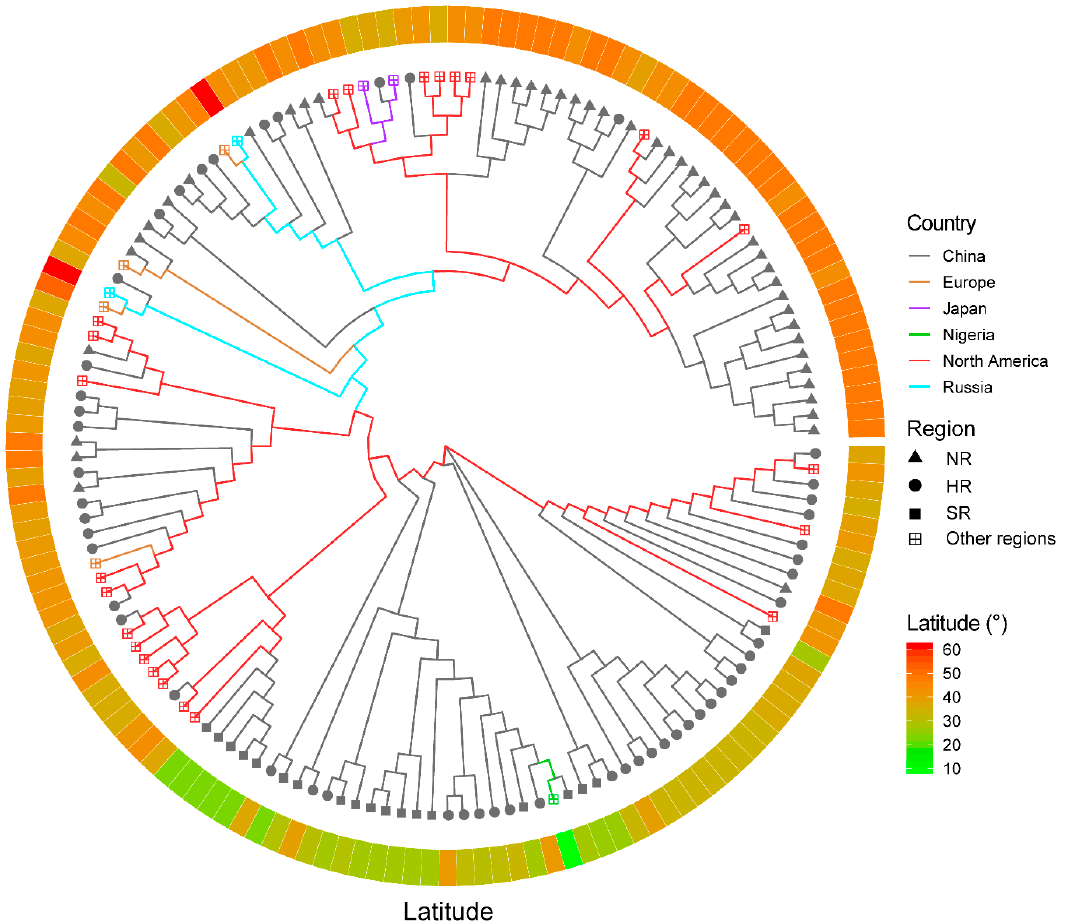
Figure 5. The phylogenetic tree for 150 soybean cultivars. The branch colours represent the countries of origin. The cultivation regions are represented by different symbols of the branches: the solid triangle represents Northern Region of China (NR), the solid circle represents Huanghuaihai Region of China (HR), the solid square represents Southern Region (SR) of China and the square with a cross inside represents other regions (the regions are out of China). The latitudes of the origins of cultivars are indicated by the ring in the outer layer, and the diverse colours represent the latitude degrees (°).